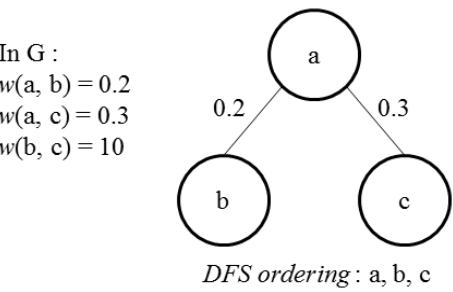
Figure 10. Incorrect band ordering given by DFS on MST